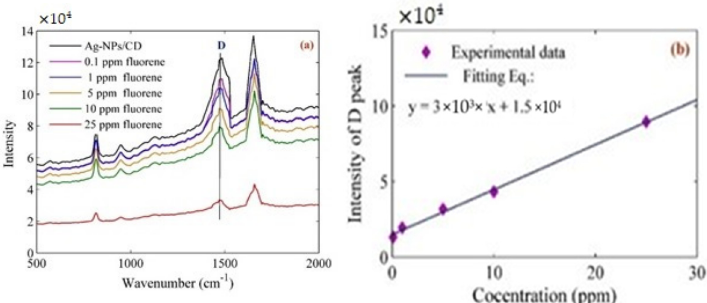
Figure 10. ( a ) Raman spectrum for the detection of low concentration (0.1, 1, 5 10, and 25 ppm) of fluoride; ( b ) variation of D band intensity with the concentration of fluoride.